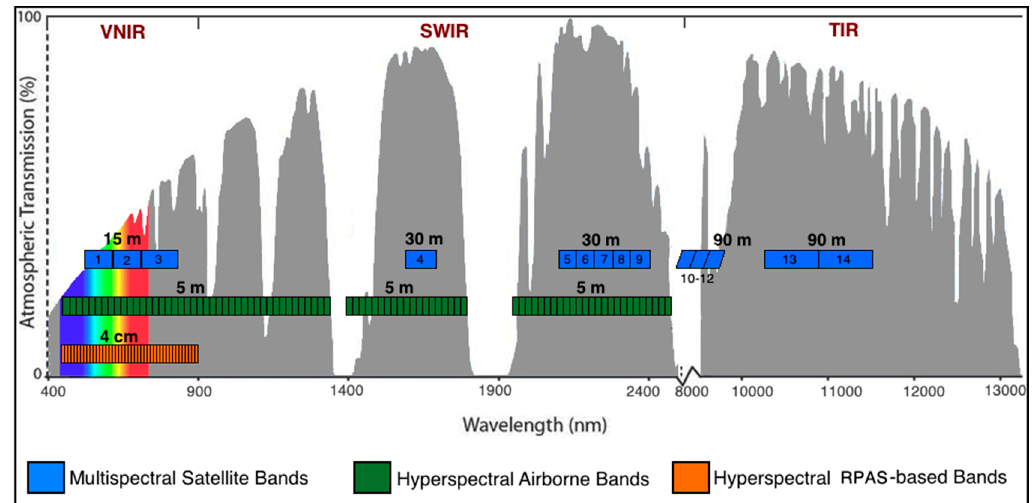
Figure 5. Diagram showing the spectral information of each data set; spectral size and range of multispectral satellite (ASTER) bands, hyperspectral airborne (HyMap) bands, and hyperspectral RPAS-based bands. The spatial resolution of the various data sets is indicated above each set of bands. Table 1. Summary of platforms and sensors utilized in this study; the parameters and general use are listed next to each